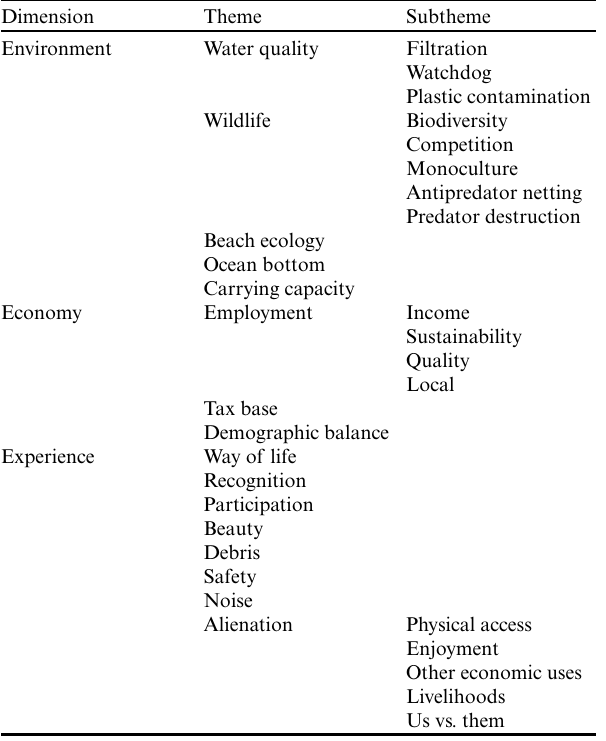
Table 1 . Perceived effects of shellfish aquaculture identified by Baynes Sound